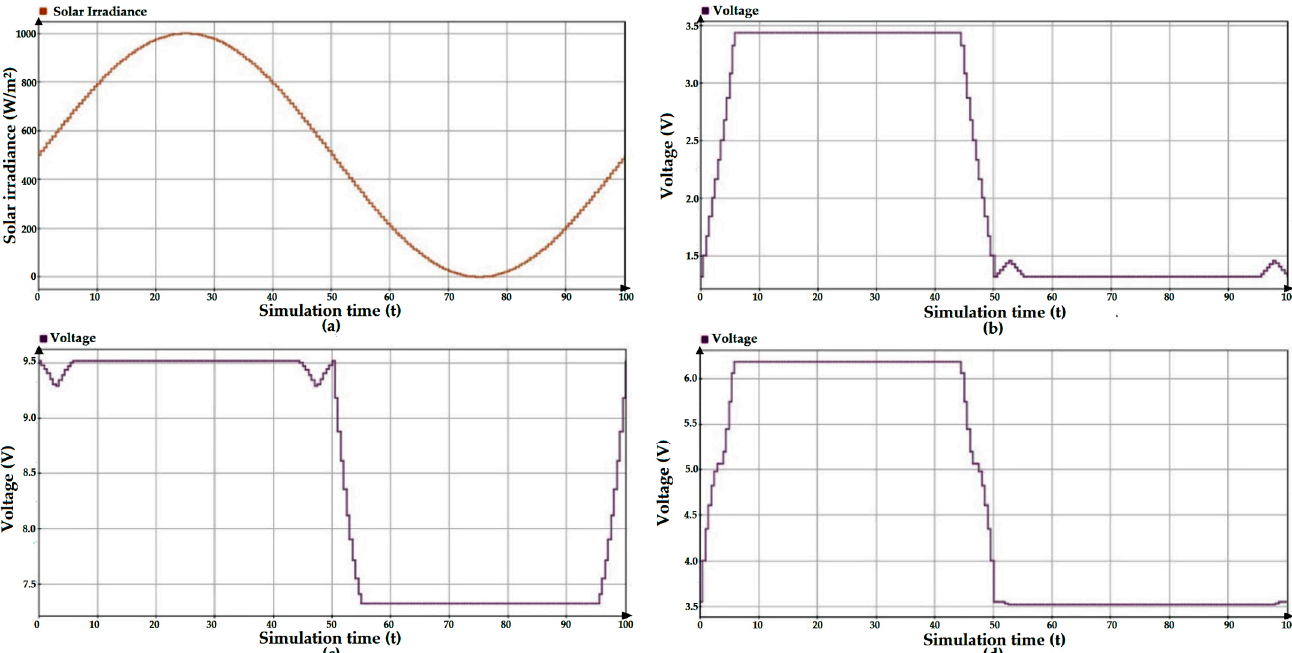
Figure 13. ( a ) Solar irradiance vs. time; ( b ) voltage vs. time at minimum water need; ( c ) voltage vs. time at maximum water need; ( d ) voltage vs. time at standard operating